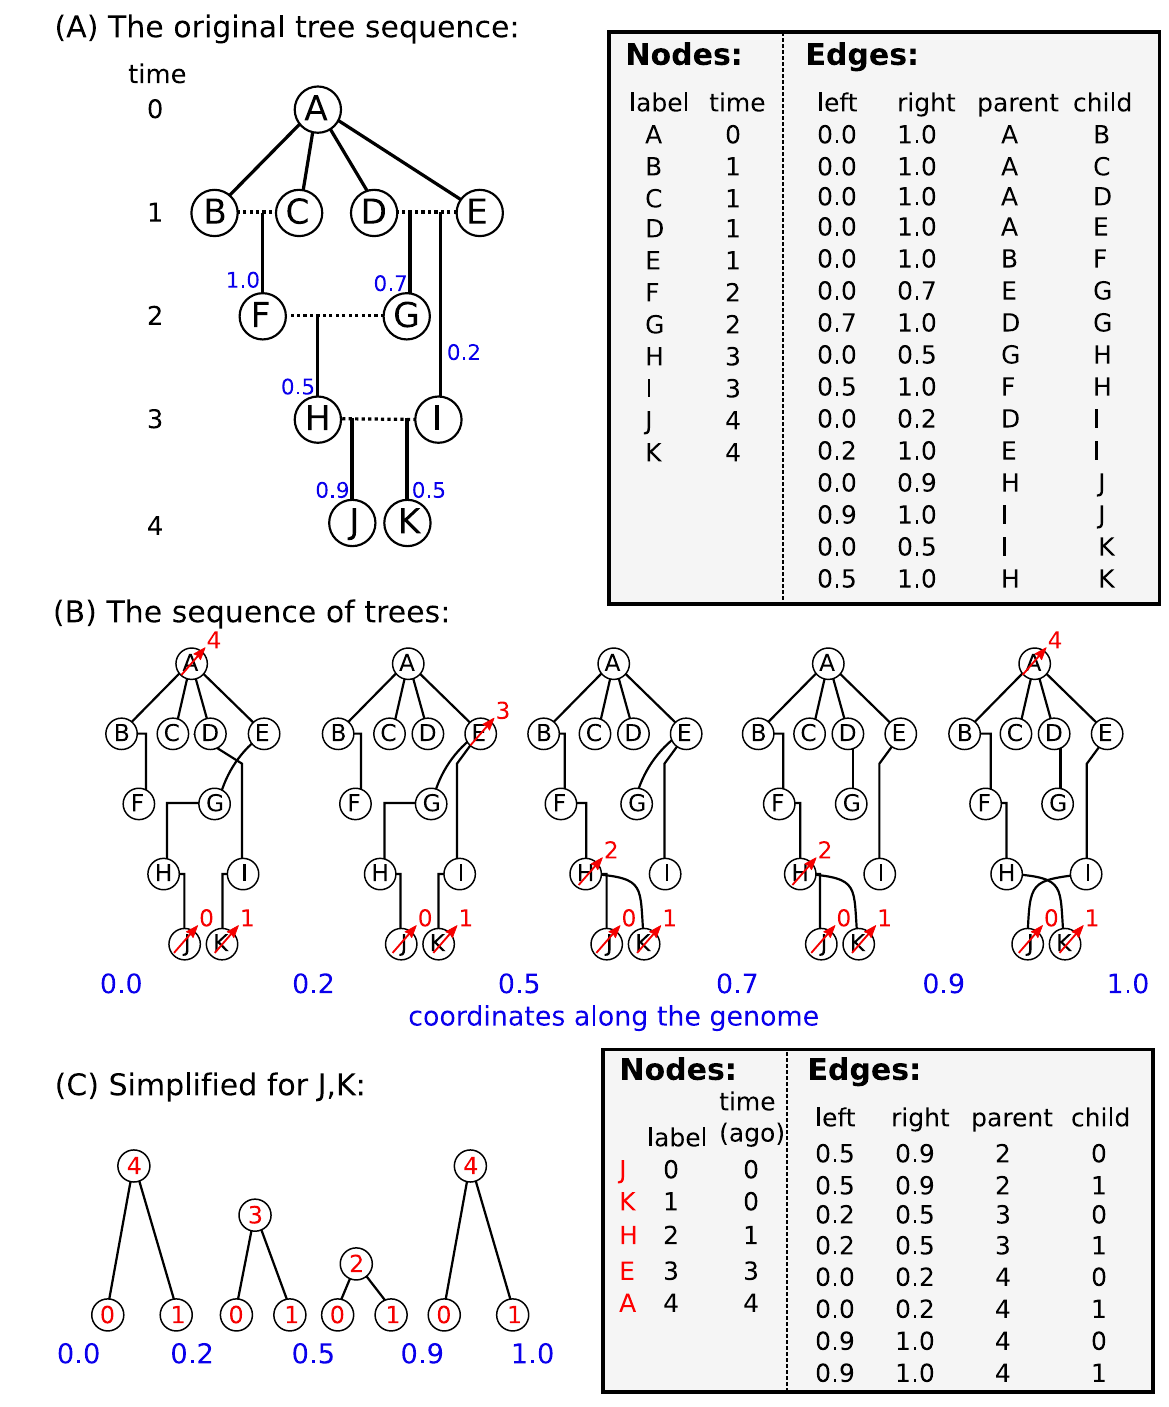
Fig 5. An example of tree sequence simplification. (A) The augmented pedigree diagram on the left relates the ten homologous chromosomes of five diploid individuals (BC, DE, FG, HI, and JK) to each other and to a common ancestral chromosome (A); dotted lines connect the two chromosomes of each individual, and solid lines lead to the products of their meioses. The corresponding tables (right) have 11 node records (one for each chromosome) and 15 edge records (one for each distinctly inherited segment). Blue numbers denote crossing over locations—for instance, D and E were parents to G , who inherited the left 70% of the chromosome from E and the remainder from D . B , C , D , and E inherit clonally from A . (B) The five distinct trees found across the chromosome (blue numbers denote locations on the chromosome). Labels after simplification are shown in red (see text). (C) Tables recording the tree sequence after simplification with nodes J and K as samples. The mapping from labels in the forwards time simulation to nodes in the tree sequence is shown in red.